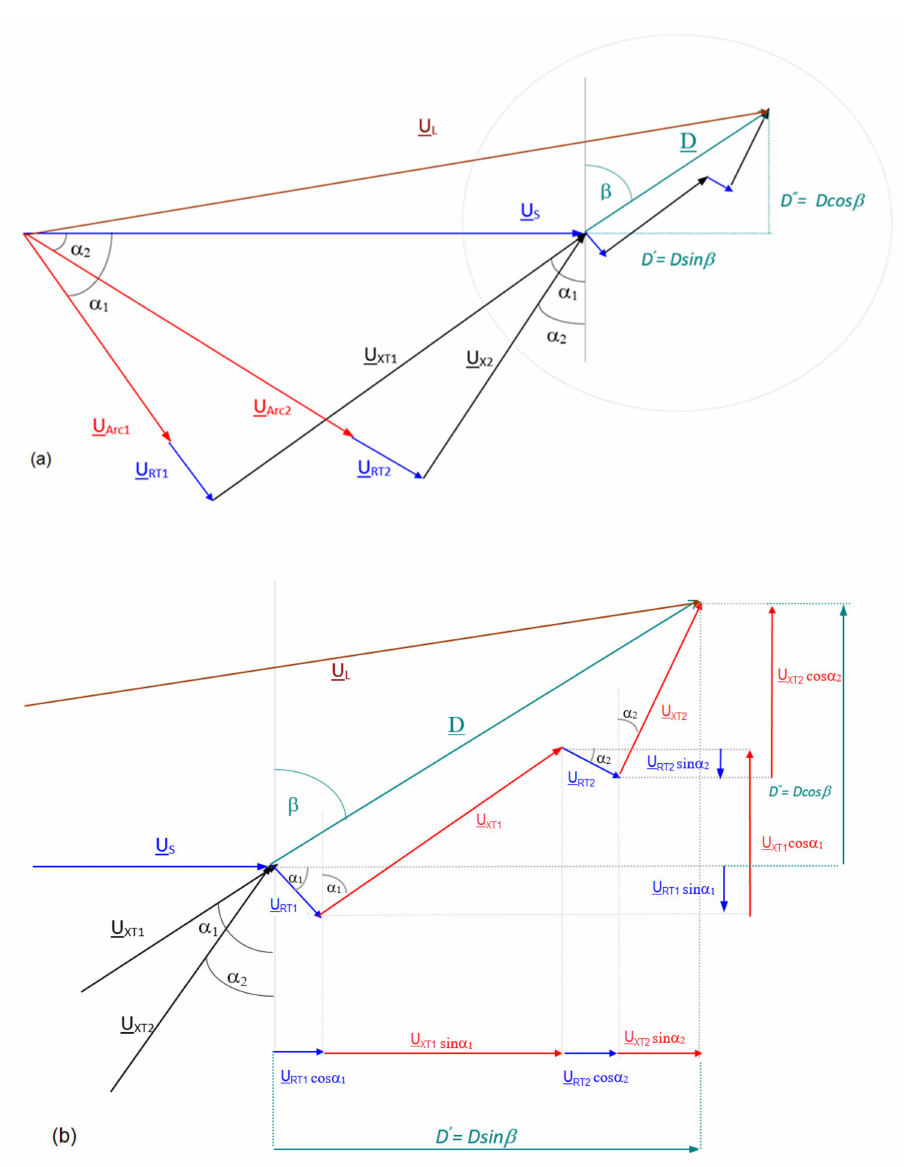
Figure 14. Vector diagram of the arc furnace currents and voltages taking into account the resistance ( a ), marked area with a circle in the magnification ( b